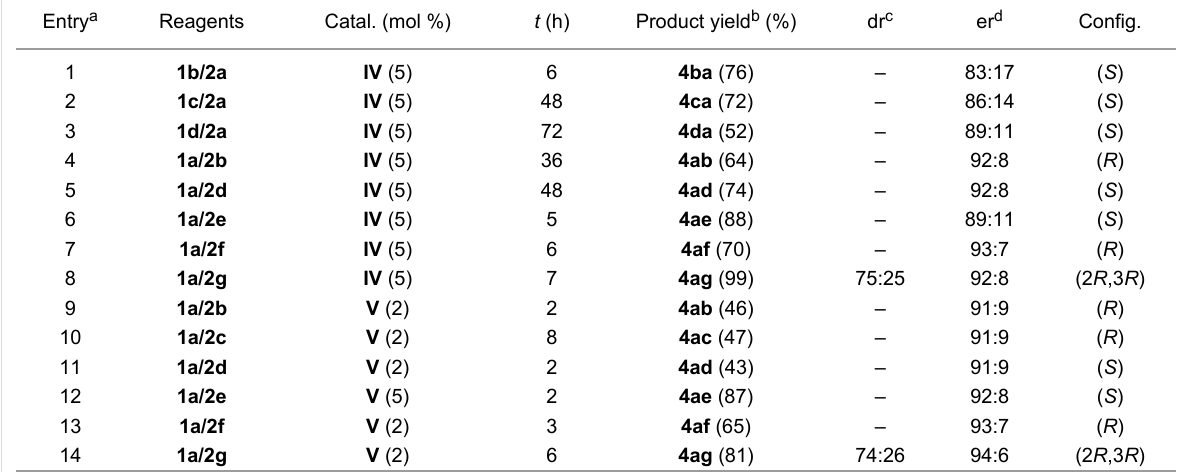
Table 2: Addition of malonates and β -diketones to nitrostyrenes catalyzed by IV and V . Entry